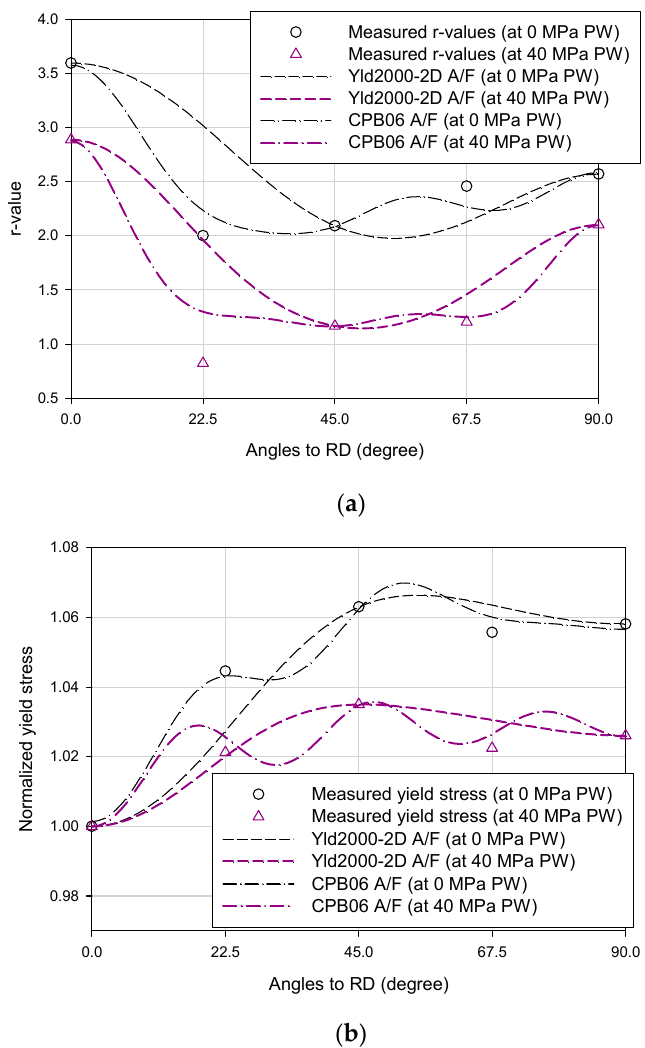
Figure 19. Comparison of the measured and calculated ( a ) r -values and ( b ) normalized yield stresses based on associated flow rule (Yld2000-2D and CPB06ex3 yield functions) for the niobium sheet.